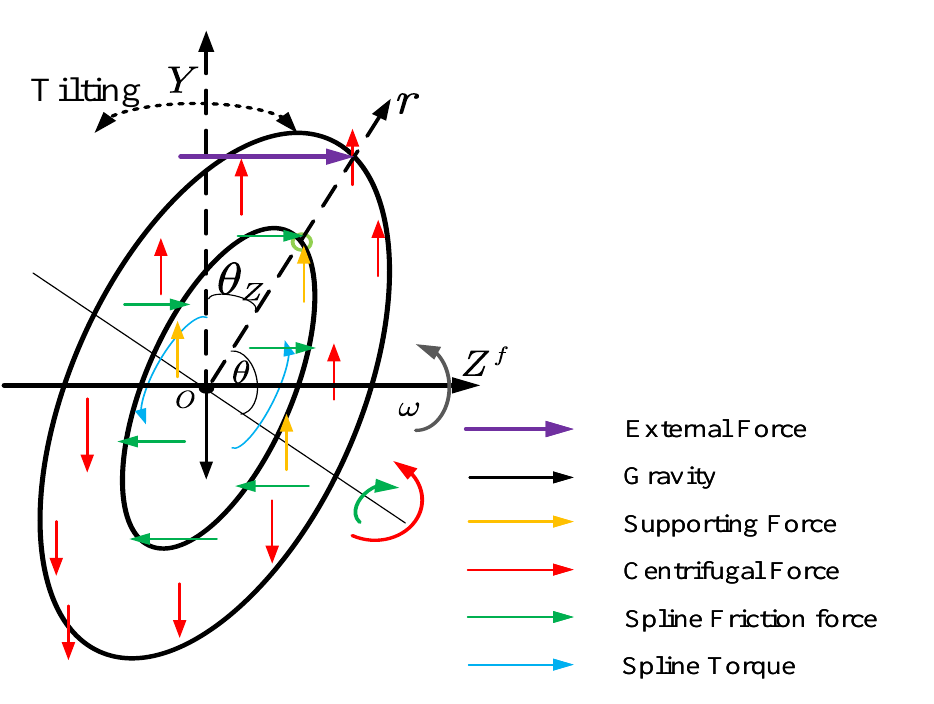
Figure 4. Force analysis of the spline-guided